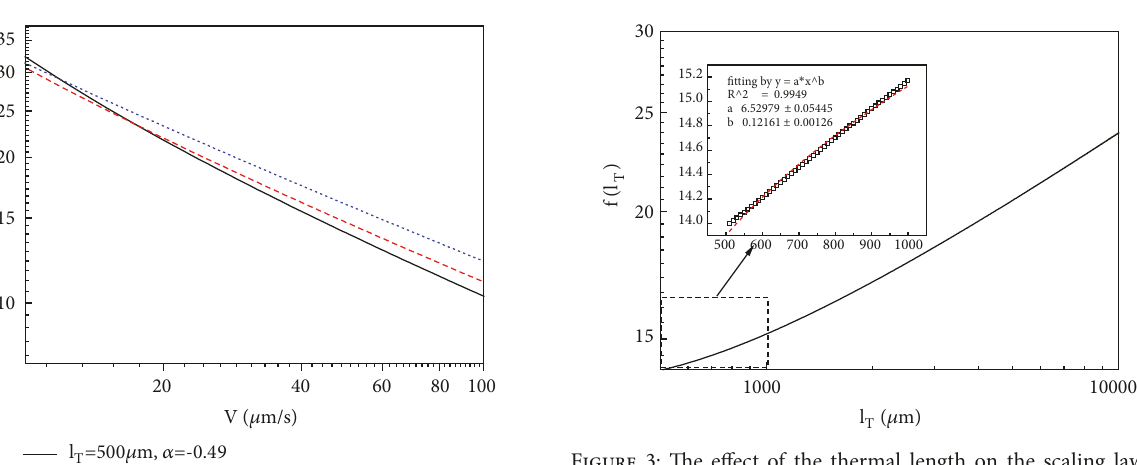
Figure 3: The effect of the thermal length on the scaling law of formula (5). The inset presents the local region with power law fitting. The corresponding parameters are 𝜆 2 ≈ 350 V −0.6 with 𝑉 =50 𝜇 m / s , a=0.1, and